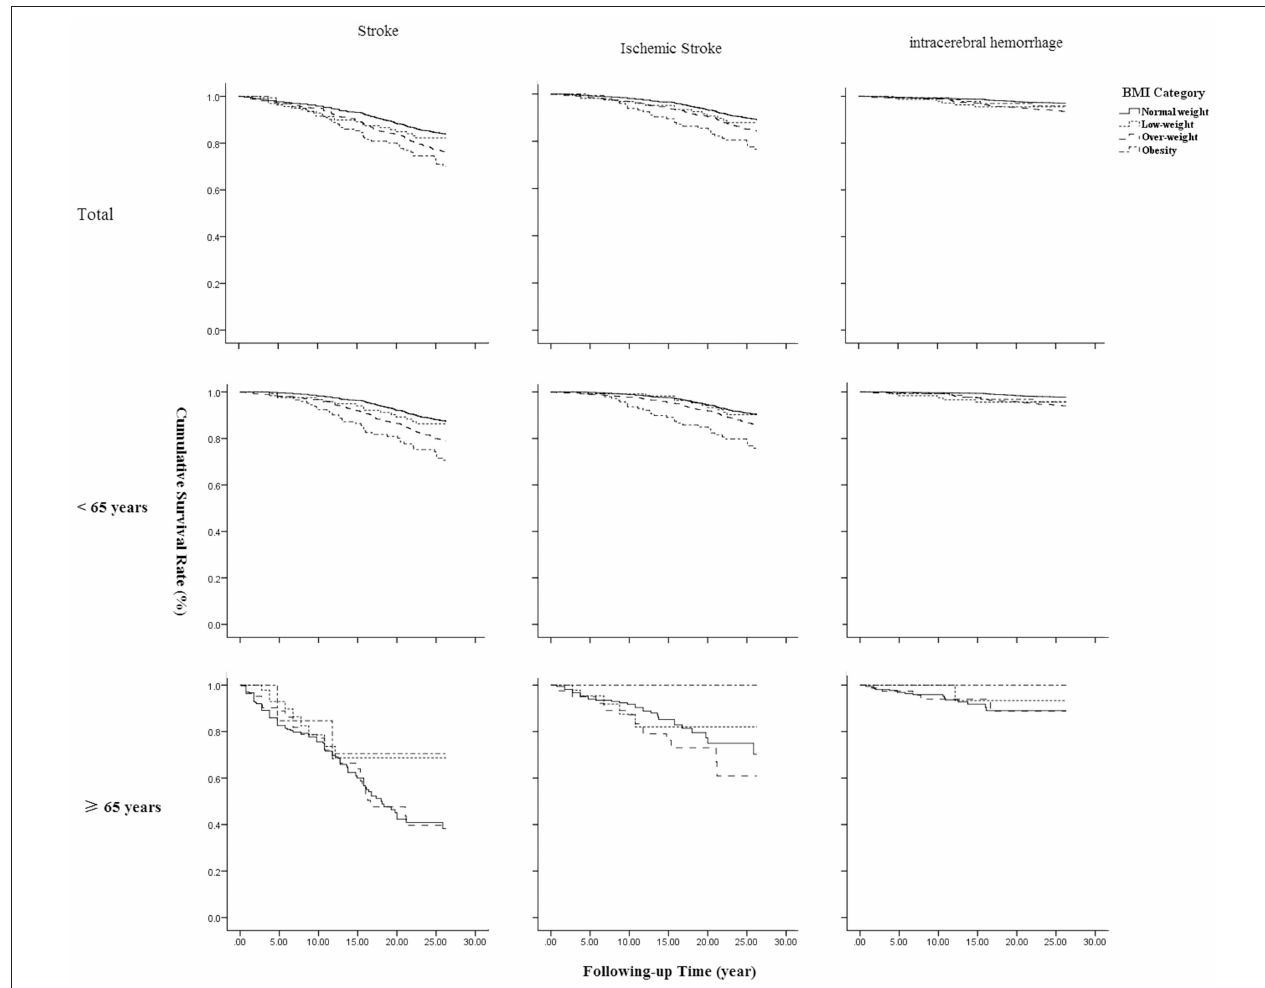
FIGURE 1 | Association of BMI with stroke survival by types and age.